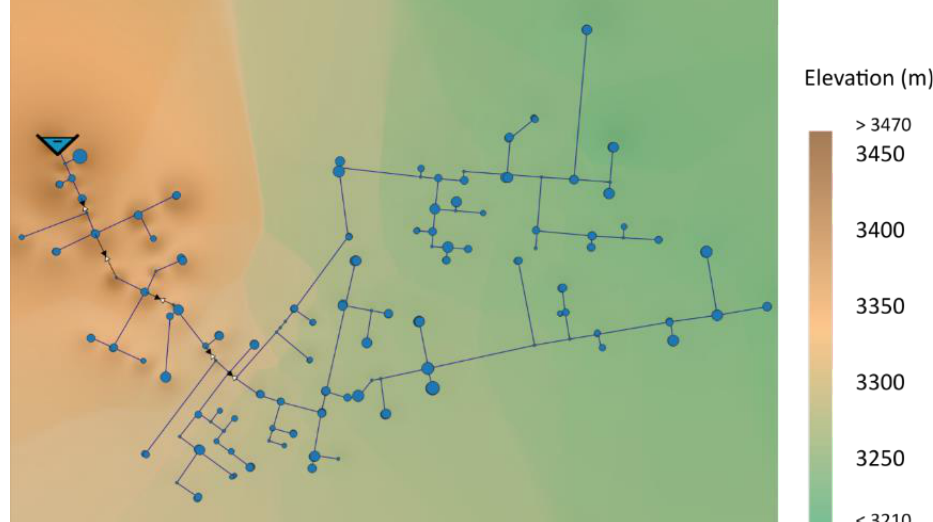
Figure 1. Planimetry of the network San Francisco de Cunuguachay.